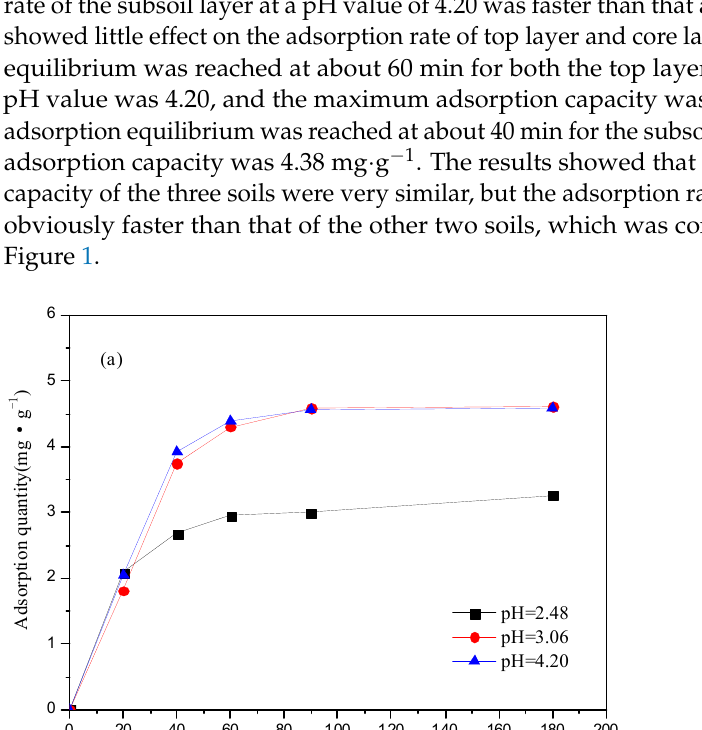
Reaction Time(min) pH=2.48 pH=3.06 pH=4.20 Figure 2. Effect of initial pH (2.48, 3.06 and 4.20) on the adsorption capacity of the three layers of soil: ( a ) top layer of loess soils; ( b ) core layer of loess soils and ( c ) subsoil layer of loess soils. (4 mg of soil, initial concentration of Fe 3+ was 300 mg·L − 1 , 25 °C). Surface charge and the functional groups on the soil surface and Fe 3+ form would be influenced by the pH value, which influenced the adsorption equilibrium [16]. Cation exchange was the main mechanism of soil adsorption of heavy metals. In general, more H + would compete with the adsorption site of Fe 3+ in the solution at a lower pH value, resulting in a lower adsorption capacity of Fe 3+ under the condition of low pH. Therefore, comparing these initial pH value, the pH value of 4.20 was more conducive to the adsorption process of soil. 3.3. Analysis of Adsorption Kinetics